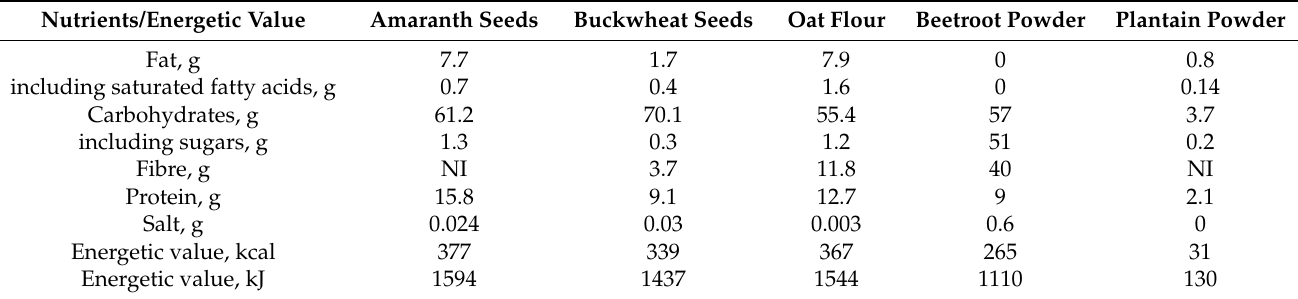
Table 1. The data were taken from the label of the ingredients indicated by the manufacturer. Table 1. Nutritional value and energetic value of ingredients *.